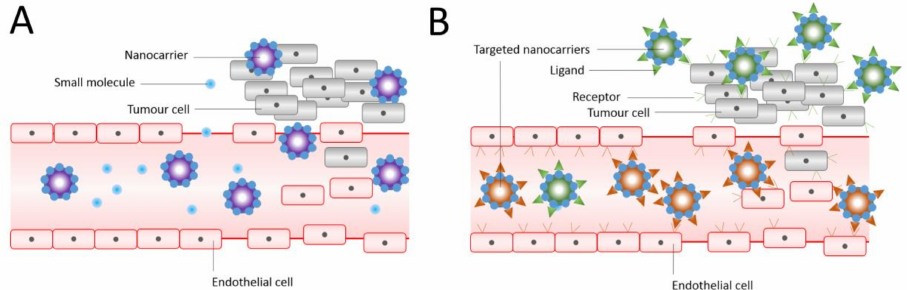
Figure 2. Passive ( A ) and ( B) active targeting of nanocarriers. Nanocarriers reach tumours